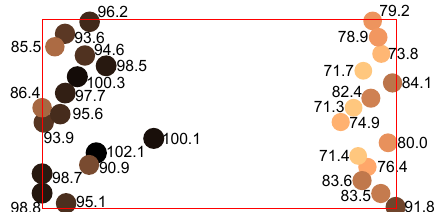
Figure 7. Optimal layout and relative power for a single wind direc- tion obtained after iteration 2. Relative power results are obtained from large-eddy simulations. Turbine locations are marked with coloured disk: size and colour scale by relative power. Plot bound- ary (red line) corresponds to boundaries of domain (cid:127) (see Fig.